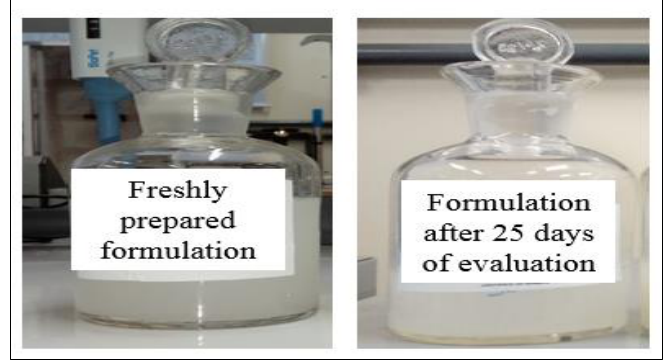
Figure 6: Organoleptic properties.